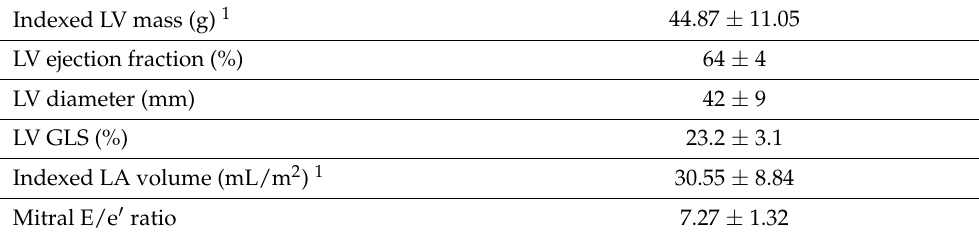
Table 2. Echocardiographic values of the cohort ( n = 64).